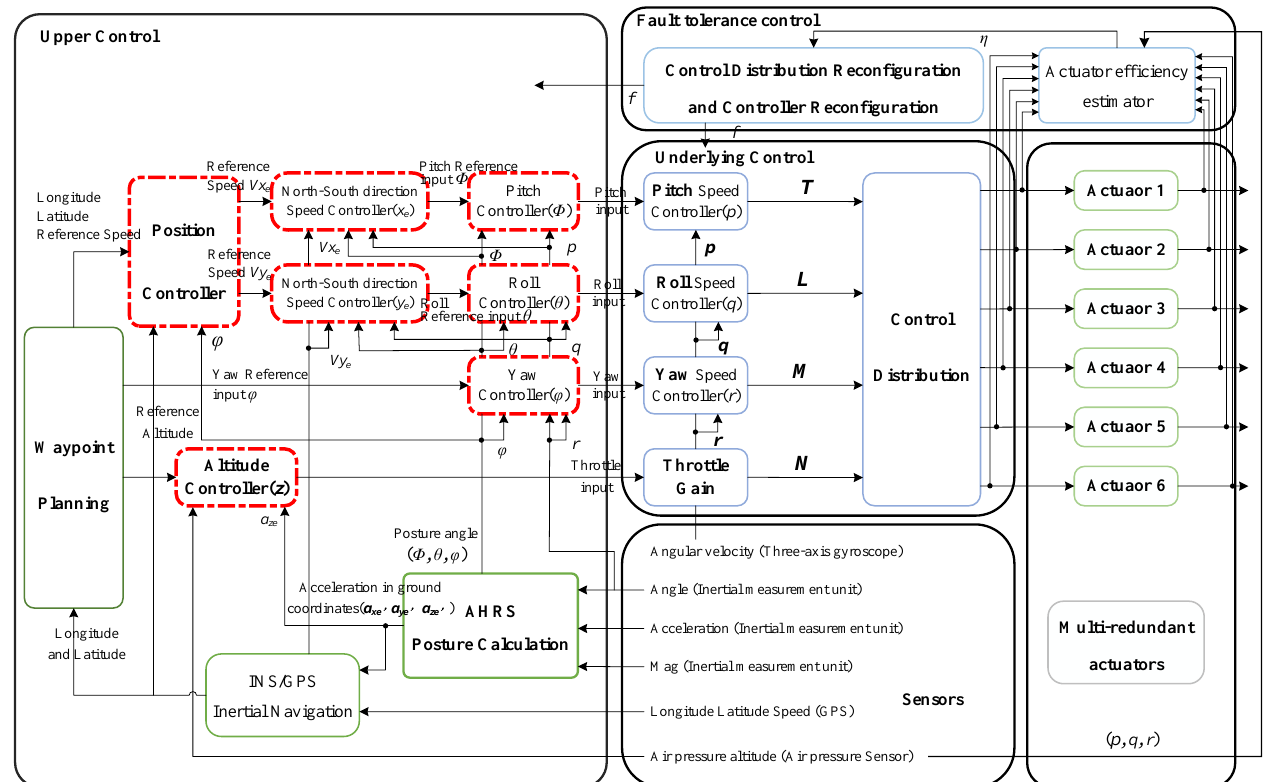
Figure 5. The structure of the control. Ignoring the coupling between the axes during the motion and considering only the motion in a small angular range, the velocity model can be assumed as Equation (5), where ˙ x 1 is the dynamic acceleration, ˙ x 2 represents the real-time velocity, and a 1 , a 2 , and a 3 are the model parameters, which can be obtained by debugging. Since the measurement result of the speed sensor is usually accompanied by a measurement delay, we add the delayed speed to the system as an extended state, and then Equation (5) can be expressed again